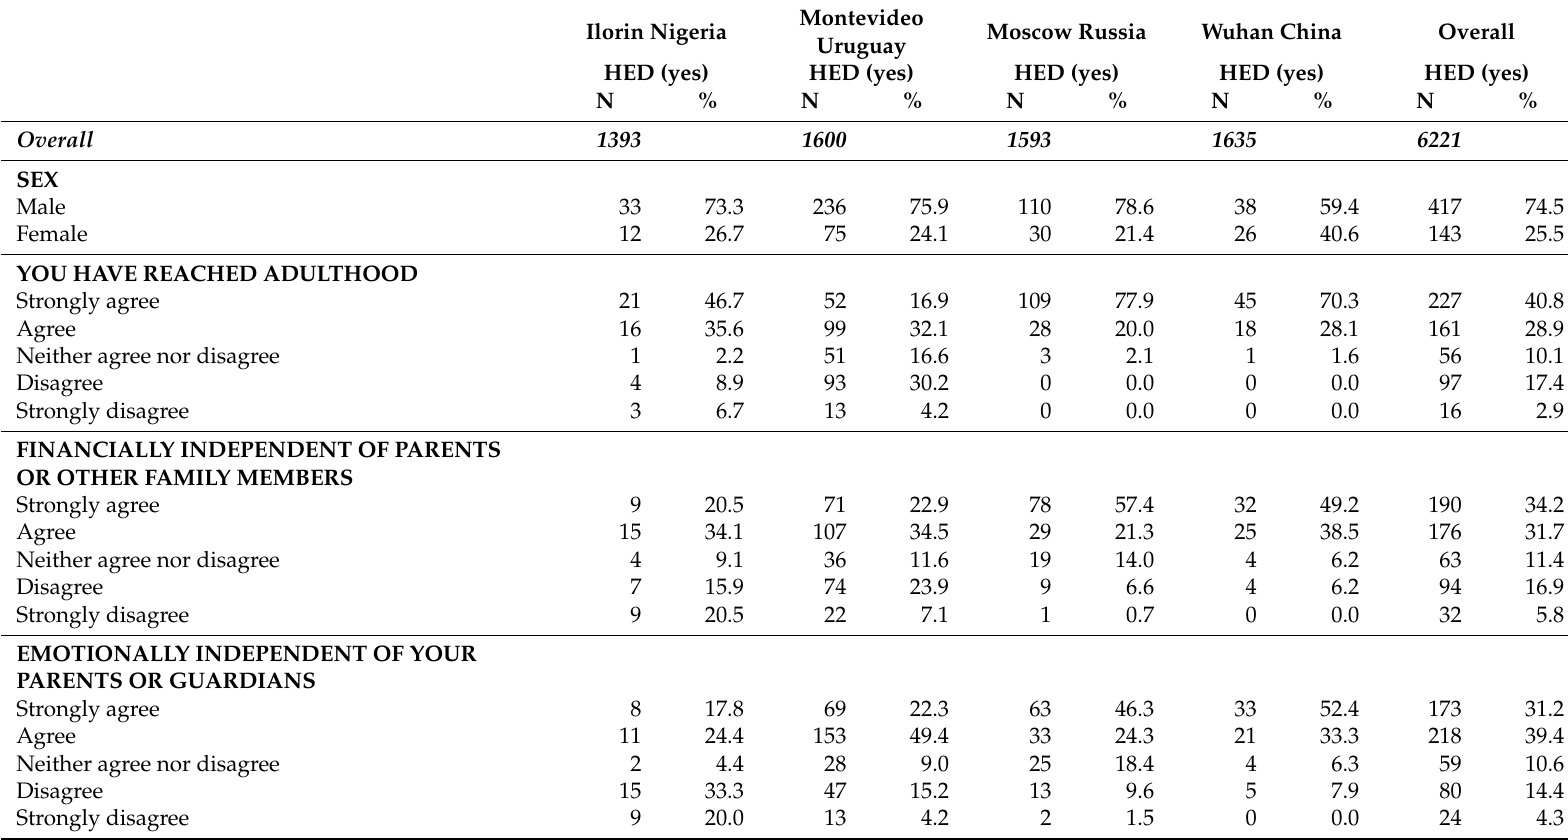
Table 2. The proportion of heavy episodic drinkers by the demographic profile of